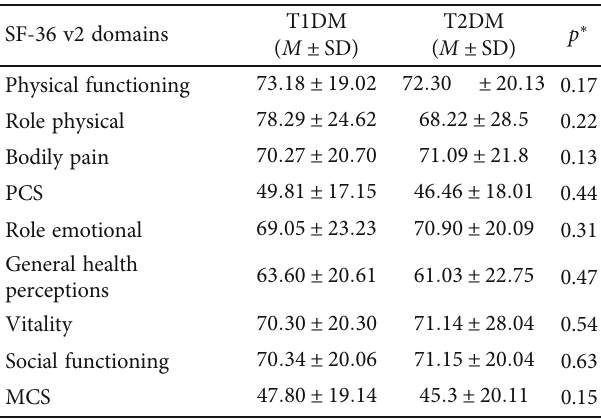
Table 3: The di ff erence in quality of life between T1DM and T2DM students.